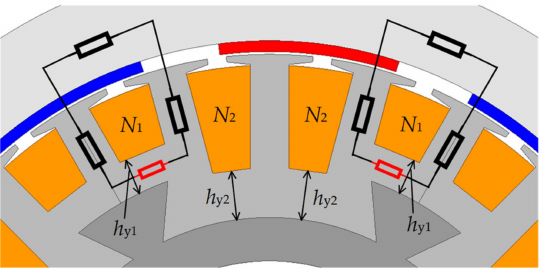
Figure 6. Main circuit of the magnetic flux generated by the coil sides with N 1 turns of the proposed machine.